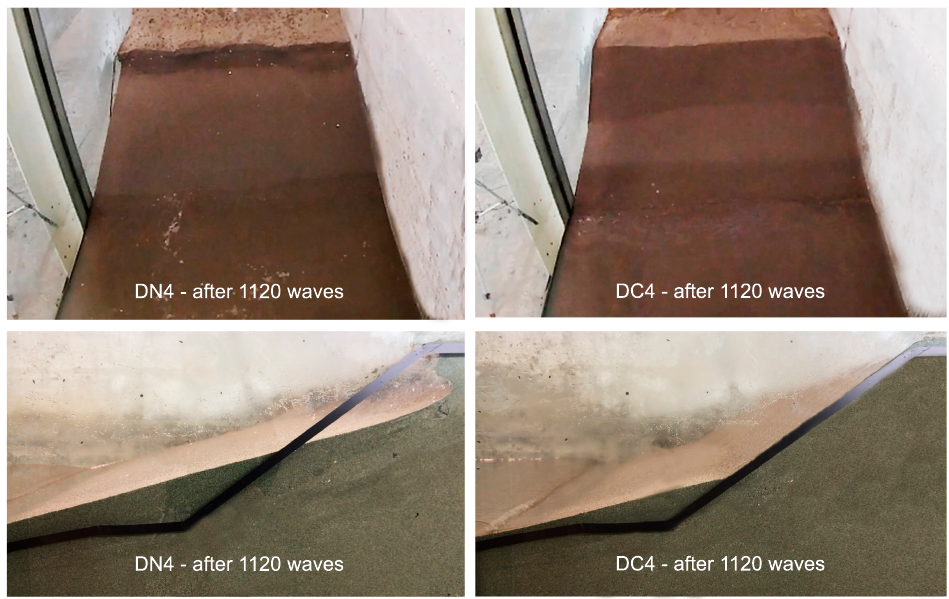
Figure 9. Front view ( up ) and side view ( down ) of cross-shore profile after four runs of DN4 and DC4.